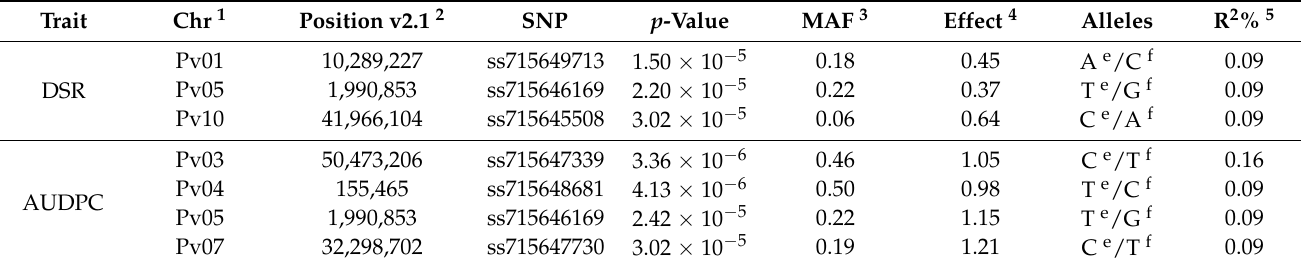
Table 3. SNPs detected for the DSR and AUDPC for the IAC18001 Fop strain for 205 common bean genotypes and 2001 SNPs: SNP’s positions in mega base pairs (Mb).